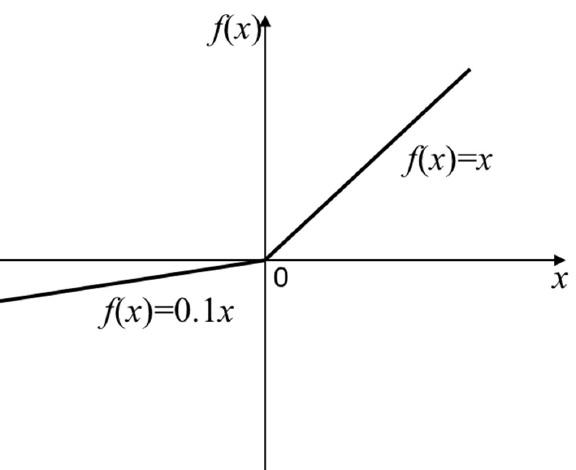
Figure 5. The curve of LReLU.